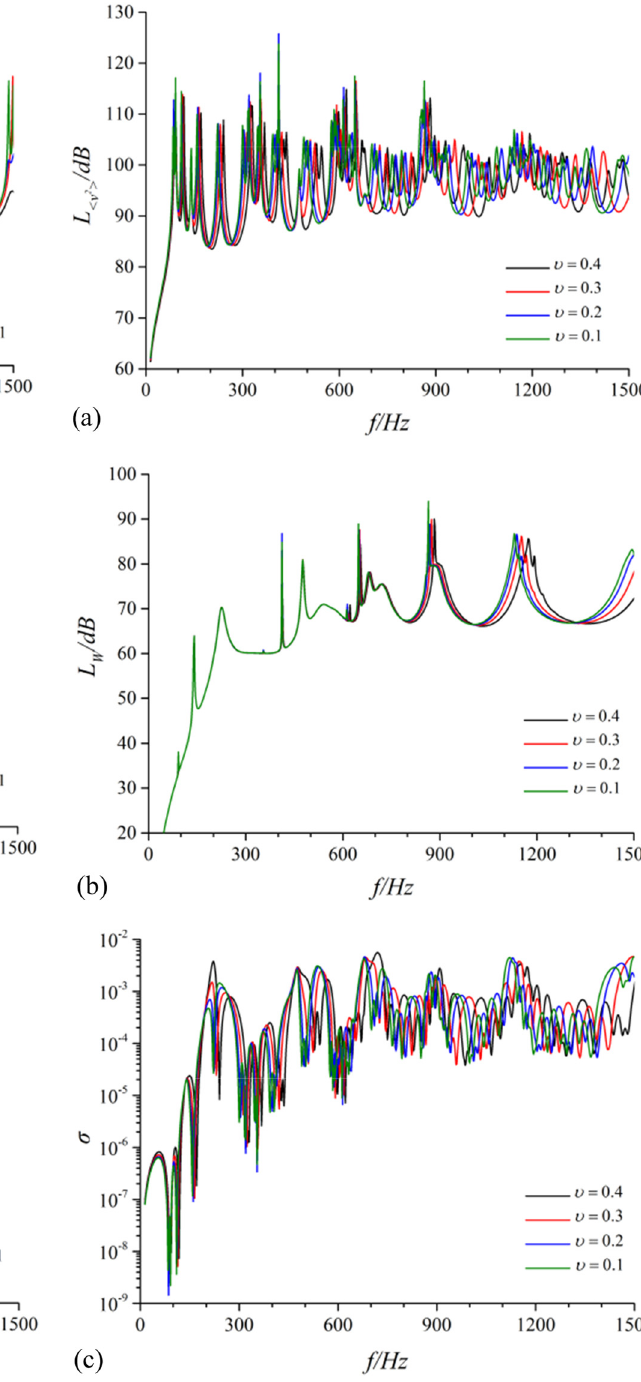
Figure 5: Contrast of vibration and noise performance for the cylindrical shell under di ff erent dissipation factors. ( a ) Radial quadratic velocity level, ( b ) sound radiation power level, and ( c ) sound radiation e ffi ciency.